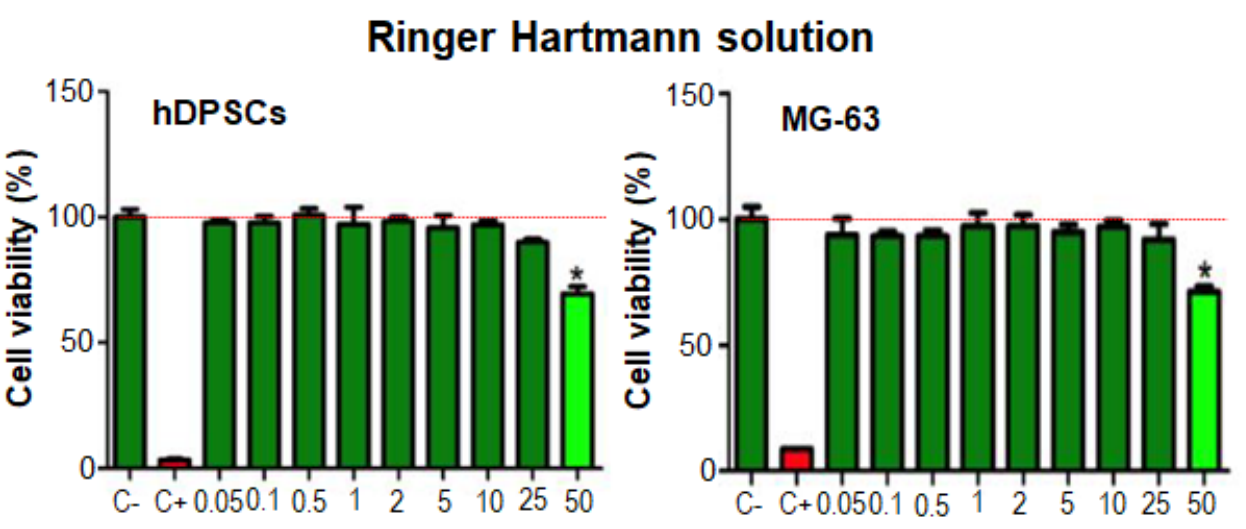
Figure 9. Measurement of the cytotoxicity of Ringer-Hartmann’s solution in cells hDPSCs and MG-63 at different concentrations. * when is p < 0.05.